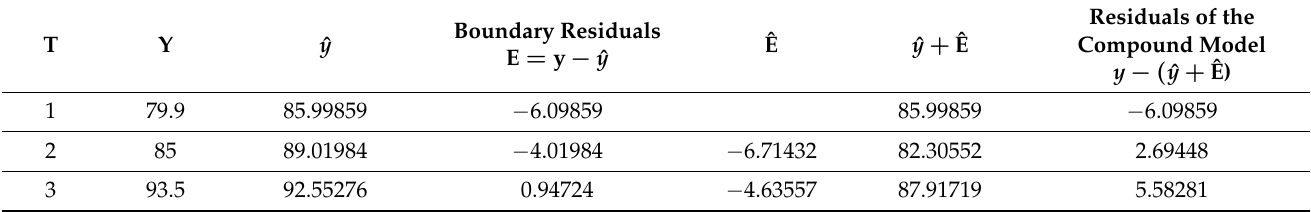
Source: Table 1, reference [3], and authors’ calculations. Table A10. Residues of the Compound